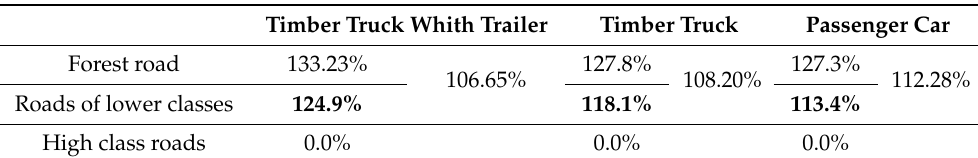
Table 3. Differentiated relative comparison of muscle load when driving a work vehicle according to the monitored type of roads (author).